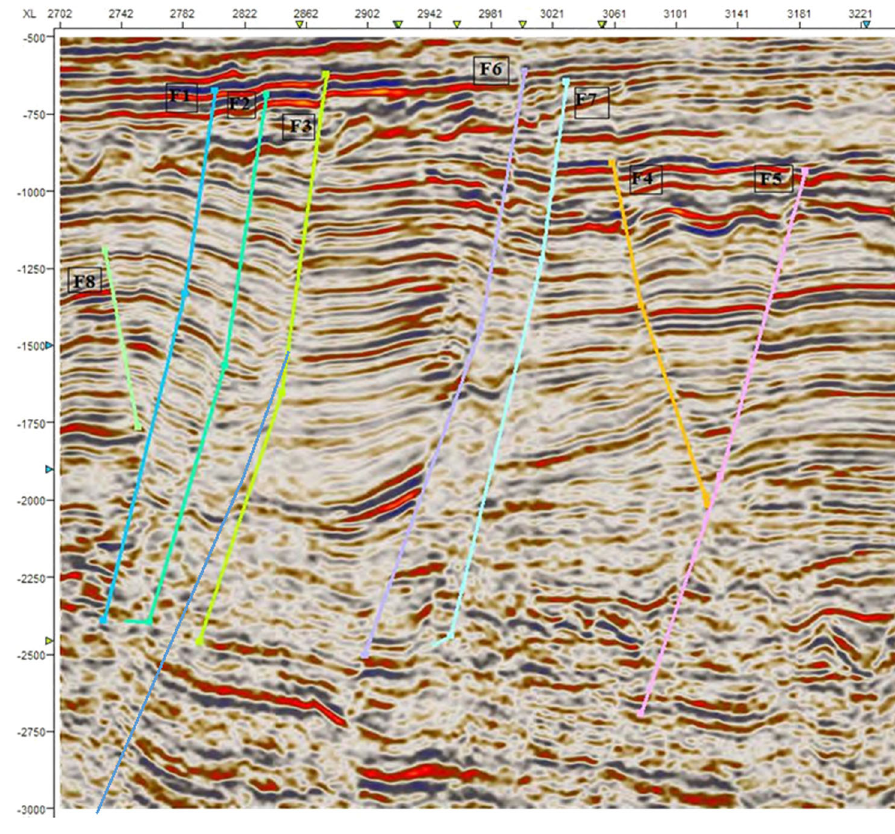
Fig. 4 The major listric faults (F3, F6 and F7) in the